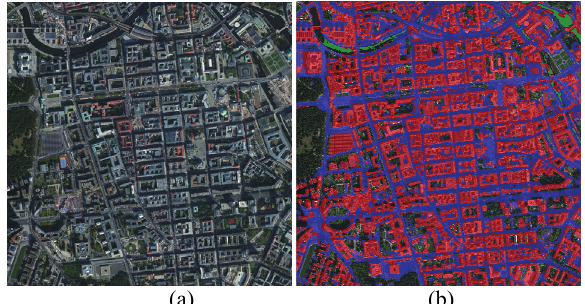
Figure 10. (a) the test optical image, and (b) the classification of building, road, river, and vegetation, where they are colored in red, blue, green, and blank.